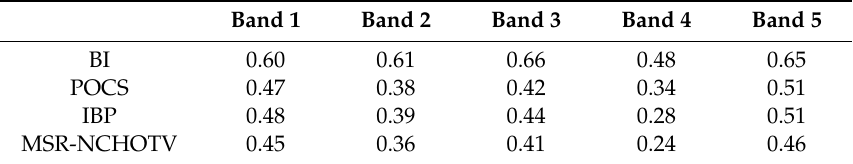
Figure 4. Results of the super-resolution reconstruction (SRR) for Experiment 1 using the ( a ) bilinear interpolation (BI), ( b ) iterative back projection (IBP), ( c ) projection onto convex sets (POCS), and ( d ) mixed sparse representation non-convex high-order total variation (MSR-NCHOTV) methods. Panels with the suffixes 1, 2, and 3 show local detail magnifications area of the corresponding panel in the left column. Table 2. Evaluation results for image sharpness. Table 2. Evaluation results for image sharpness.